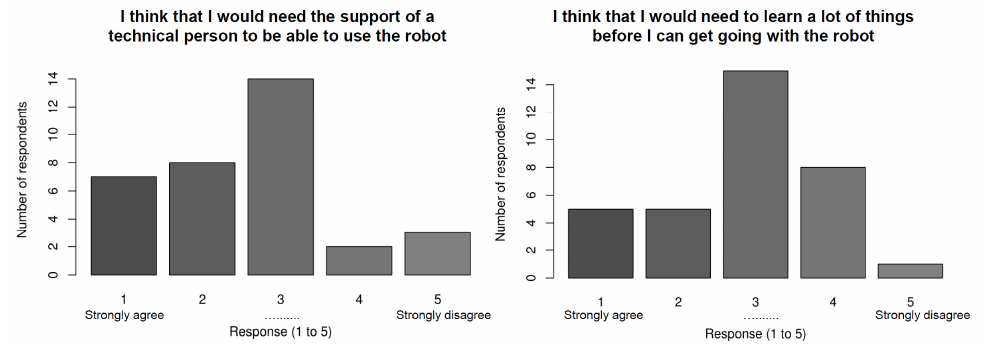
Figure 5. Results for the SUS items ( n = 34). Table 5. Results for UEQ-S ( n = 34). * p values <